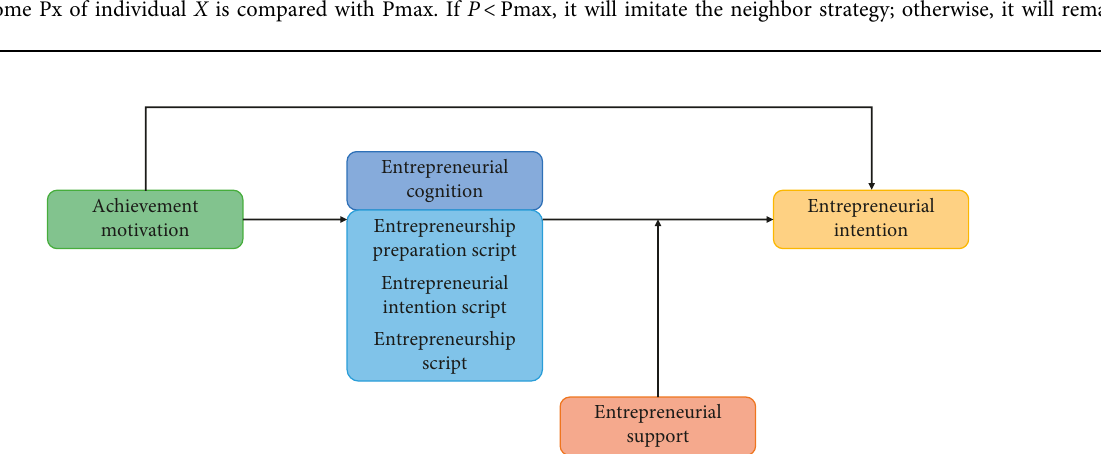
Figure 8: The cognitive intention and path choice model of college students’ entrepreneurship under the cooperation of individual and